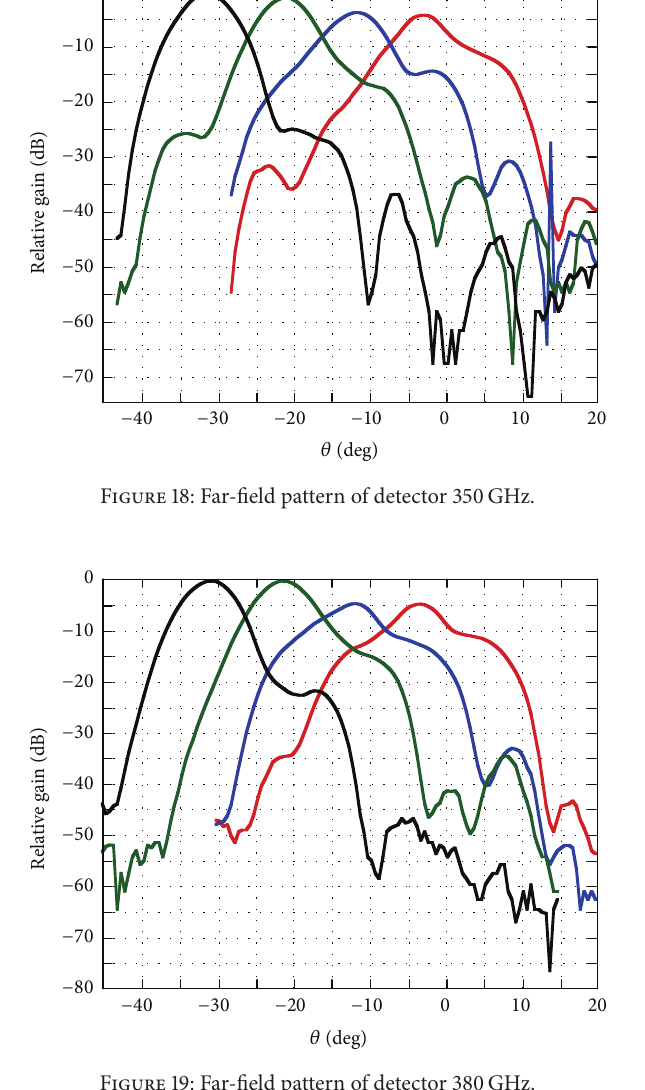
Figure 19: Far-field pattern of detector 380 GHz.